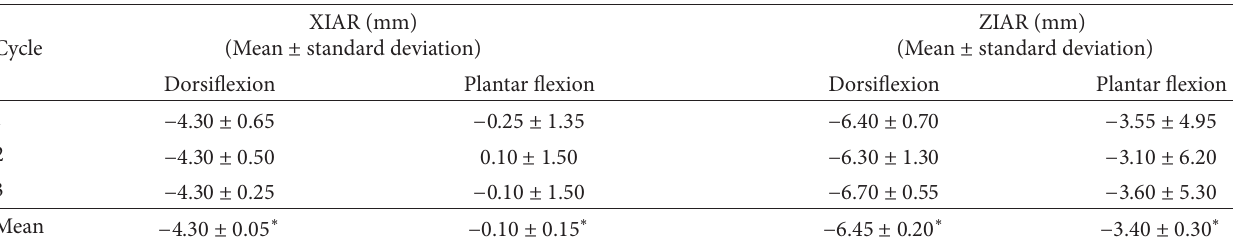
Figure 5: Kinematic and load control strategy. (a) Kinematic coordinate frames of the foot and ankle defined by the NTT and extended tool tip (ETT) of the RTP. The ETT (orange dot) represents the initial prescribed IAR of the foot located at the center of the talus and was a negative 𝑍 offset from the NTT. The coordinate frame of the load cell was initially located at the center of the load cell and transformed to the origin of the moving joint center, that is, the ETT. (b) An angular input of ankle rotation was given every 0.5 degrees, during which the loading protocol reduced the ankle moment due to off-axis forces by minimizing the distance ( Δ𝑋,Δ𝑍 ) between the pARA (upper) and the true ARA (lower), thus creating a “pure moment” condition. Table 3: Mean IAR values for specimen 2.